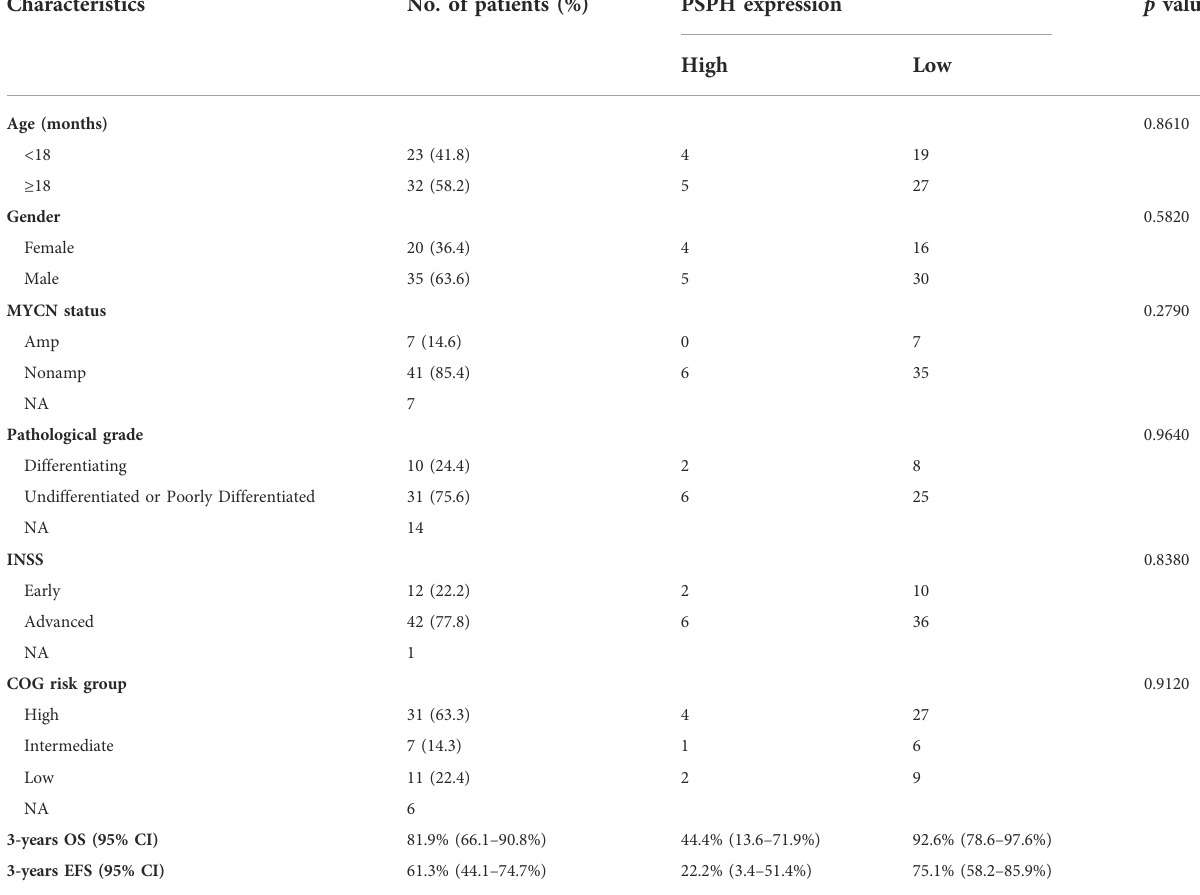
TABLE 1 Clinicopathologic characteristics of 55 neuroblastoma patients.